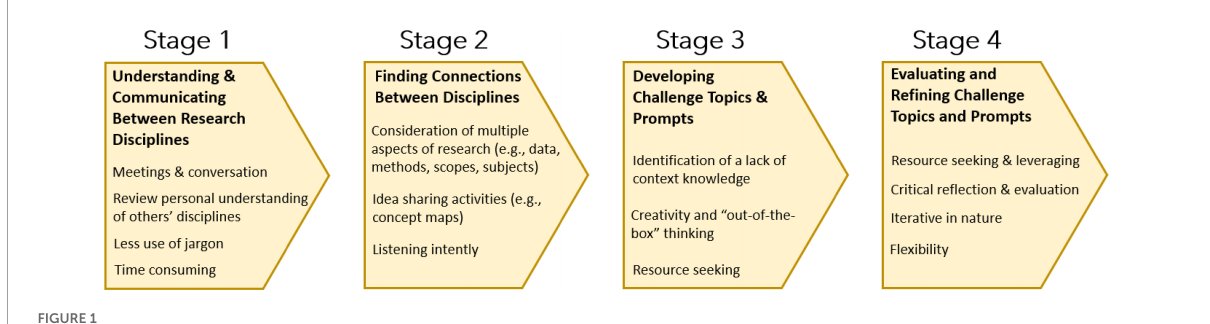
FIGURE1 Summary of the four stages of interdisciplinary hackathon development.